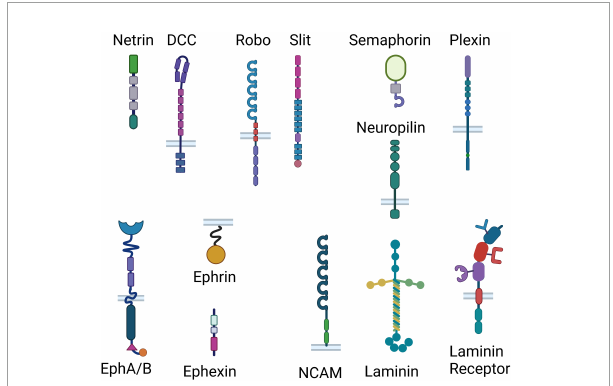
FIGURE2 Representation of the classical guidance cue systems and adhesion proteins involved in axonal guidance. Different effects of chronic stress ultimately result in removal of synapses and reduction in neurotransmission, suggesting that different stressors may induce the same outcome through shared mechanisms. Here we show cartoon representations of the domain arrangements of the classical guidance cue families (Netrin, Slit, Semaphorin, Ephrin/Ephexin) and their receptors (inserted in bilayer), as well as cell adhesion proteins (laminin, NCAM and laminin receptor). From top to bottom, Netrin consists of a laminin-like domain, 3 epidermal growth factor (EGF) domains, and a Netrin-like domain; DCC consists of 4 Ig (immunoglobulin) domains, 6 fibronectin III-like